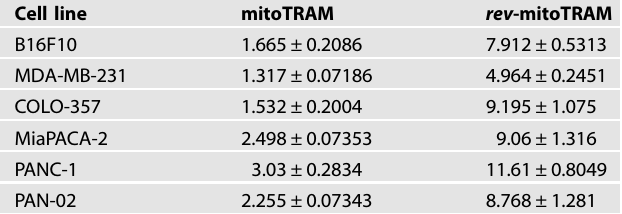
Table 1. EC 50 values ( μ M) of different cancer cell lines of mitoTRAM-34 and rev